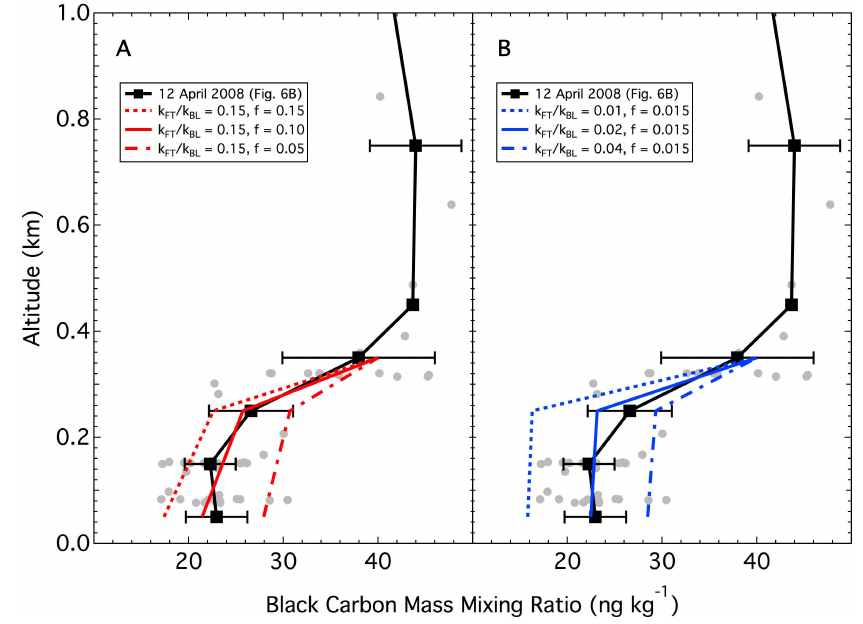
Fig. 11. Observed (black lines) and simulated (red and blue lines) vertical profiles of BC mass for measurements from 12 April 2008 (mean profile from Fig. 6B). The 30s BC data (gray points) are binned by altitude at 100m resolution below and at 500 m resolution above 500m altitude. The error bars are one standard deviation around the mean in each bin. The removal efficiency factor, f , is varied for a constant exchange coefficient ratio in (A) and vice versa in (B) . The solutions denoted by the solid red and blue lines are used to estimate the deposition flux of BC mass to the